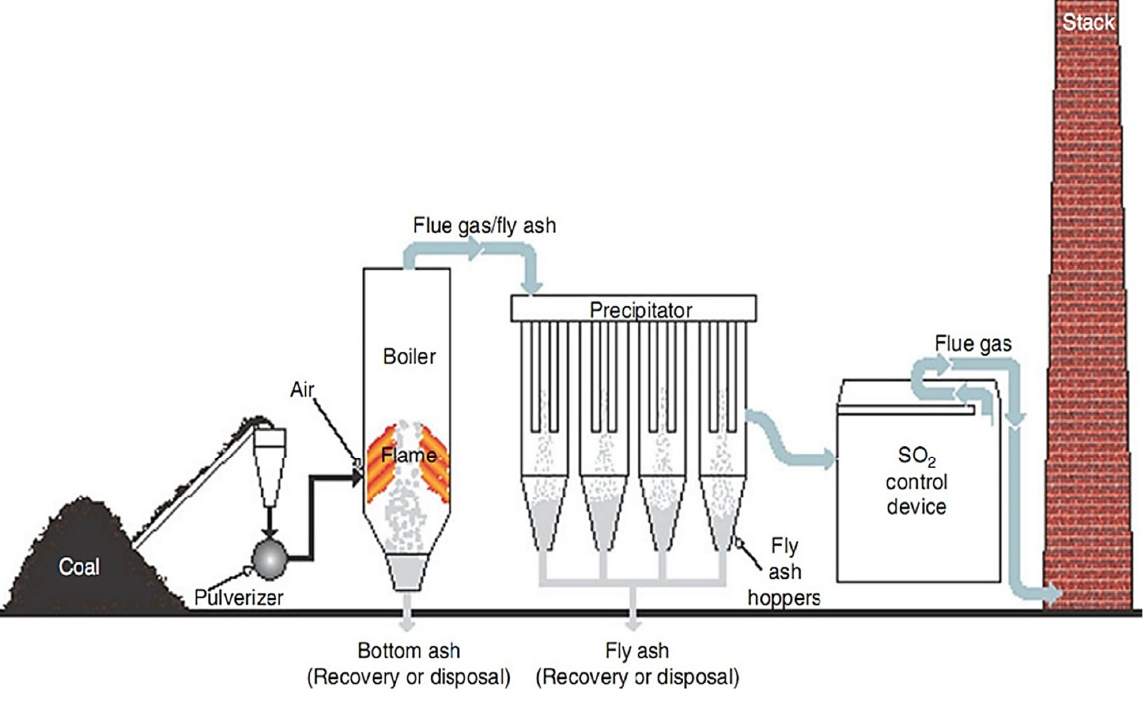
Figure 9. Clean production of FA. Adapted from [84].